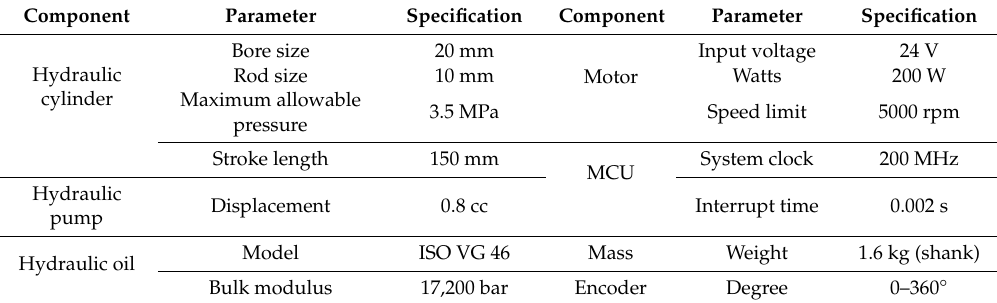
Figure 11. The experimental setup: ( a ) hardware configuration including encoder, loadcell, and force-sensing resistor (FSR); ( b ) schematic of experimental configuration; ( c ) EHA unit with motor and pump; ( d ) microcontroller unit and motor driver for motor control. Table 3. Detailed hydraulic parameters for the EHA